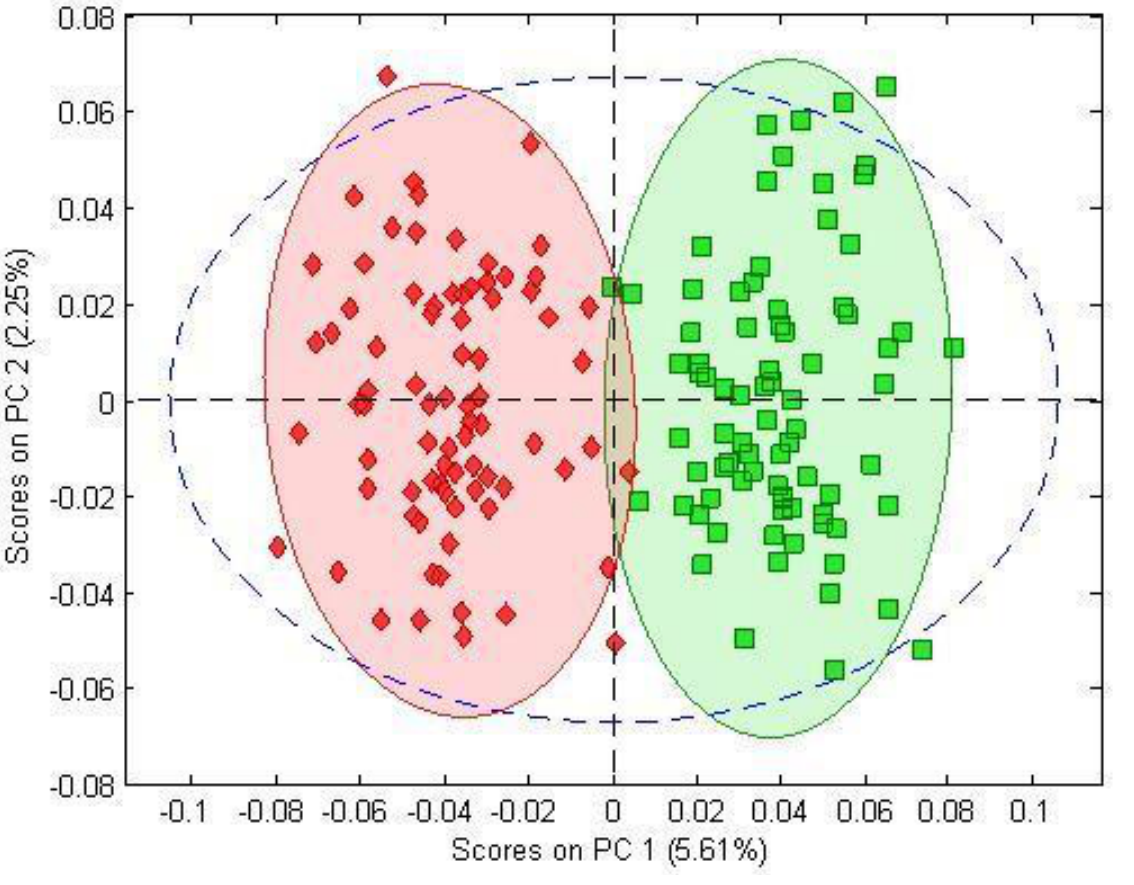
Figure 1. PC1-versus-PC2 score plot resulting from the decomposition of FTIR data with PCA obtained from control samples (red rhombuses) and BPC 157-treated samples (green squares).